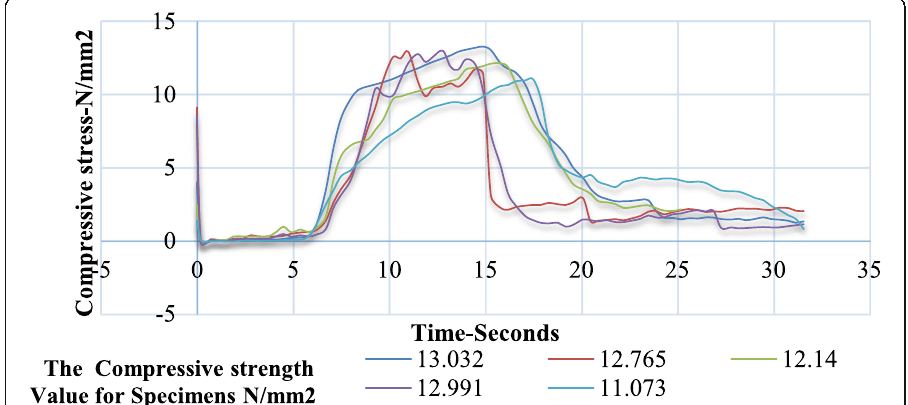
Fig. 13 Compressive strength test results — steel filing ratio